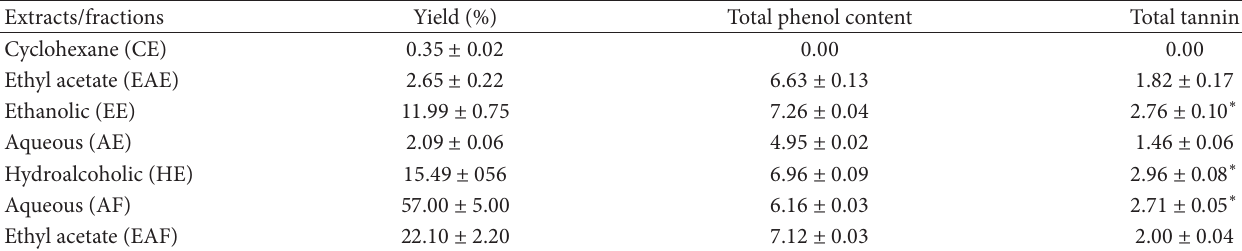
Table 1: Yields, total phenols, and tannins from Hymenaea stigonocarpa extracts and fractions.